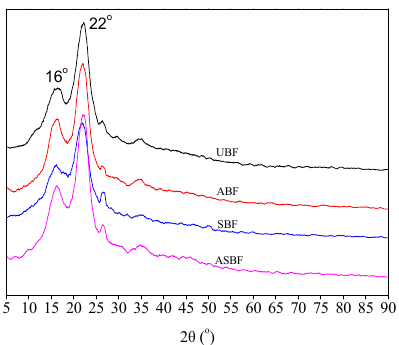
Figure 6. XRD patterns of BF modified by various methods.